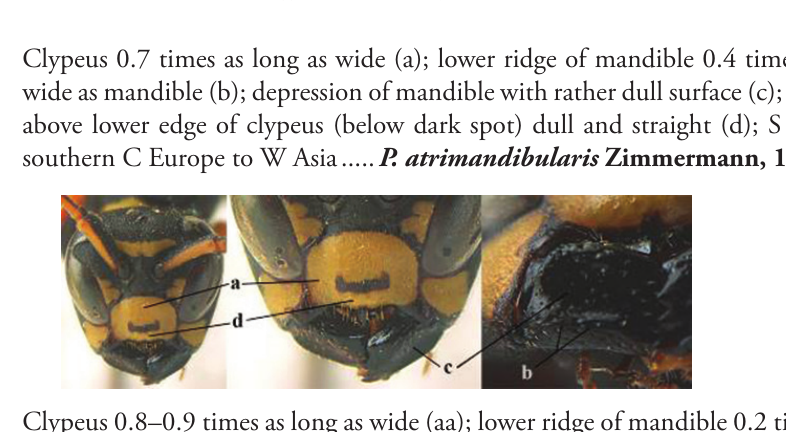
– Clypeus 0.8–0.9 times as long as wide (aa); lower ridge of mandible 0.2 times as wide as mandible (bb); depression of mandible with shiny surface (cc); area above lower edge of clypeus (below dark spot) shiny and distinctly convex